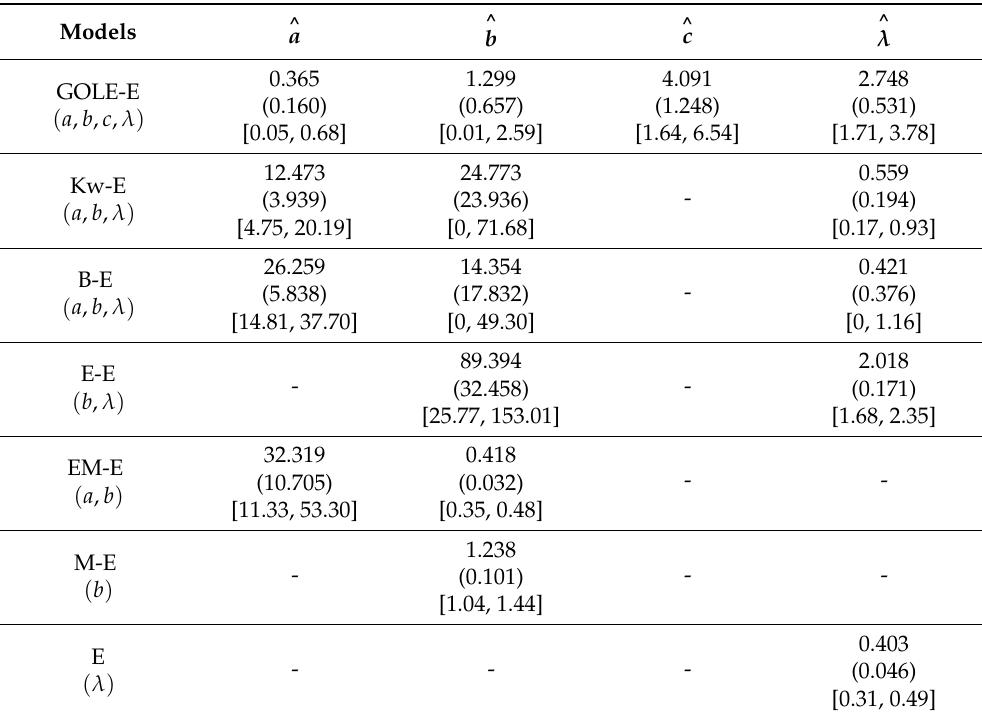
Table 5. MLEs, standard error (in parentheses) and confidence interval values [in brackets] for data set II.